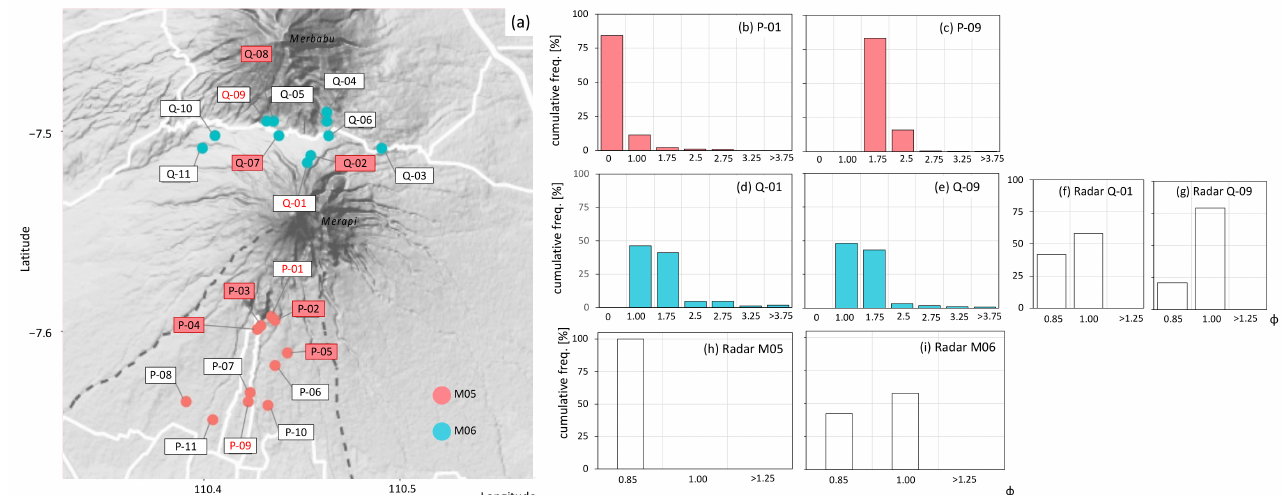
Figure 5. Left image ( a ) is the location of in situ sampling points of grain size ( φ ) for both event cases, digitized from [24]. Available data in [24] are Q-01, Q-09, P-01, and P-09, as presented in the cumulative frequency of GSD in ( b – e ) as indicated in the top right panel. M05 is given by P-01 and P-09 and M06 is given by Q-01 and Q-09 (M06). The cumulative frequency GSDs in ( f , g ) are extracted from radar-retrieved GSD for Q-01 and Q-09 (M06), respectively. Panels ( h , i ) give the cumulative frequency of GSD M05 (data are merged from P-01, P-02, P-03, P-04, and P-05) and M06 (data are merged from Q-01, Q-02, Q-07, Q-08, and Q-09). The x -axis on the GSD histogram is the lower limit of φ = − log 2 D